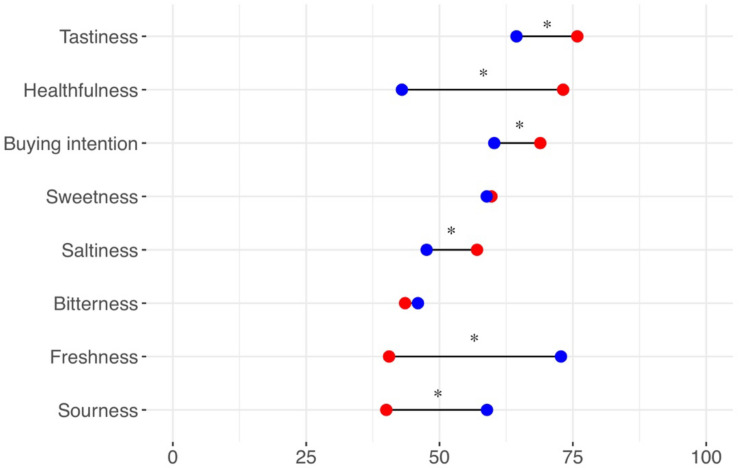
An illustration of temperature–taste attribute matching. The match between temperature words (warmth, coolness) and sensory/hedonic attributes was rated using a scale ranging from 0 (not at all) to 100 (very much). Red circles represent the mean data for warmth. Blue circles represent the mean data for coolness. An asterisk indicates a significant difference at p < 0.006 (0.05/8).